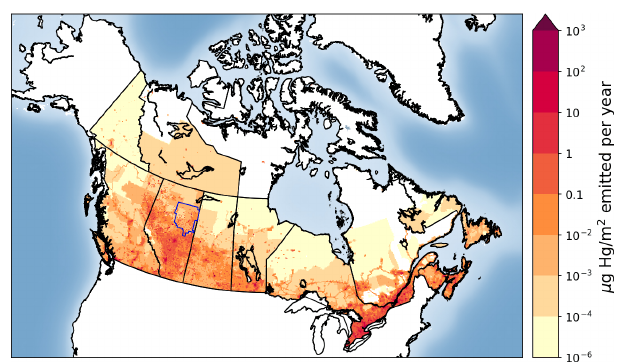
Figure 1. Spatial distribution of anthropogenic Hg emissions in Canada in 2015 ( ∼ 4.3tyr − 1 ). The Athabasca oil sands region is indicated with an approximate rectangular blue shape within north- eastern Alberta, bordering